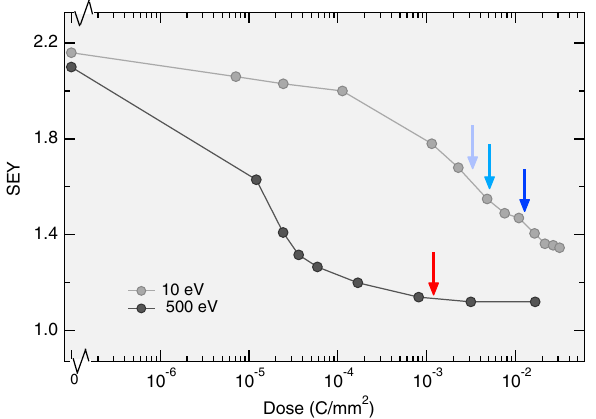
FIG. 1. (cid:1) values measured on colaminated Cu samples for max LHC beam screen as a function of the electron dose at E p ¼ 500 eV (dark grey) and 10 eV (light grey) [20]. The arrows indicate the doses used in this